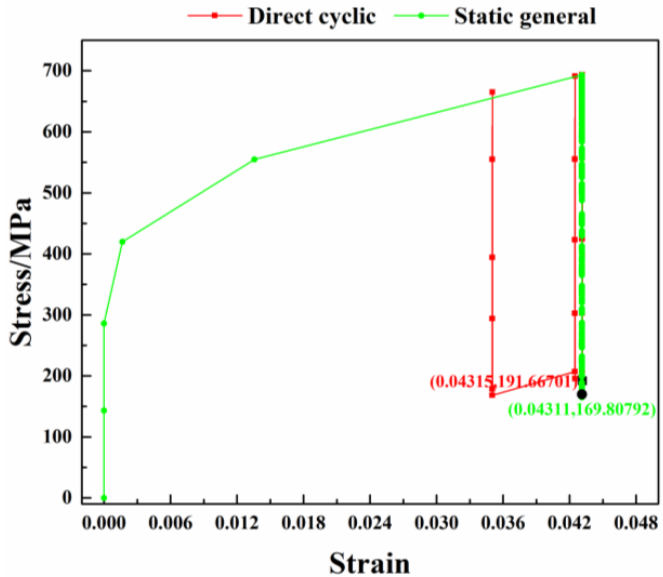
Figure 9. The stress-strain curves of two analysis steps.